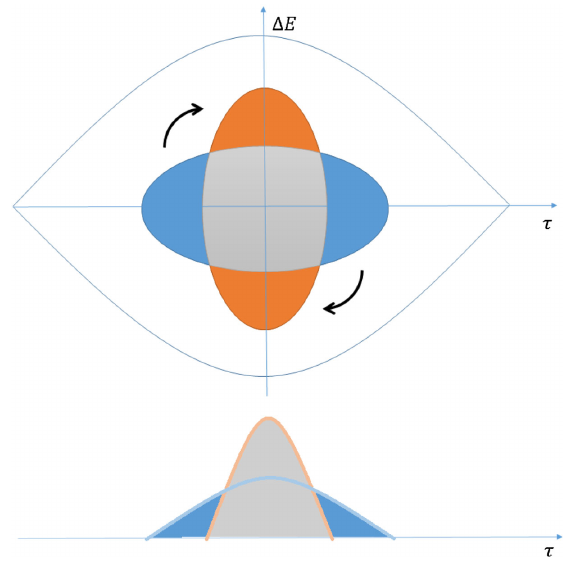
FIG. 4. Schematic presentation of the quadrupole oscillations. The upper figure represents the distribution in the phase space ( τ , Δ E ), the lower one the corresponding longitudinal profile λ ð τ Þ , which is the projection of the bunch distribution in the τ dimension. The distribution is shown at two different times, in blue when the bunch length is the biggest and in orange when it is the smallest. The matched area (grey) does not contribute to the quadrupole oscillations, the mismatched area is in